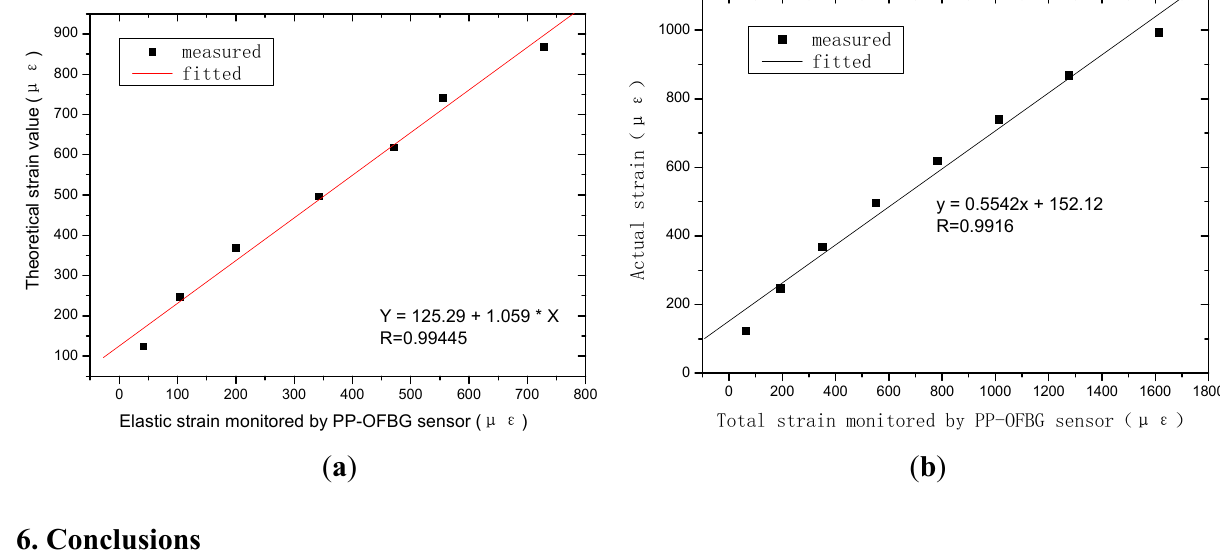
Figure 17. Strain of asphalt beams in static load test: ( a ) Theoretical strain; ( b ) Actual